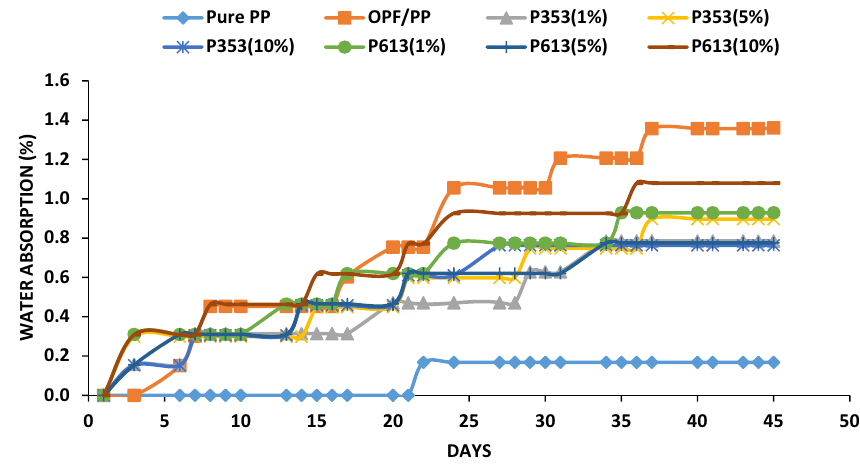
Figure 10: Water absorption of the pure PP, uncoupled, and coupled 20% OPF/PP polymer composite with two coupling agent types of di ff erent weight